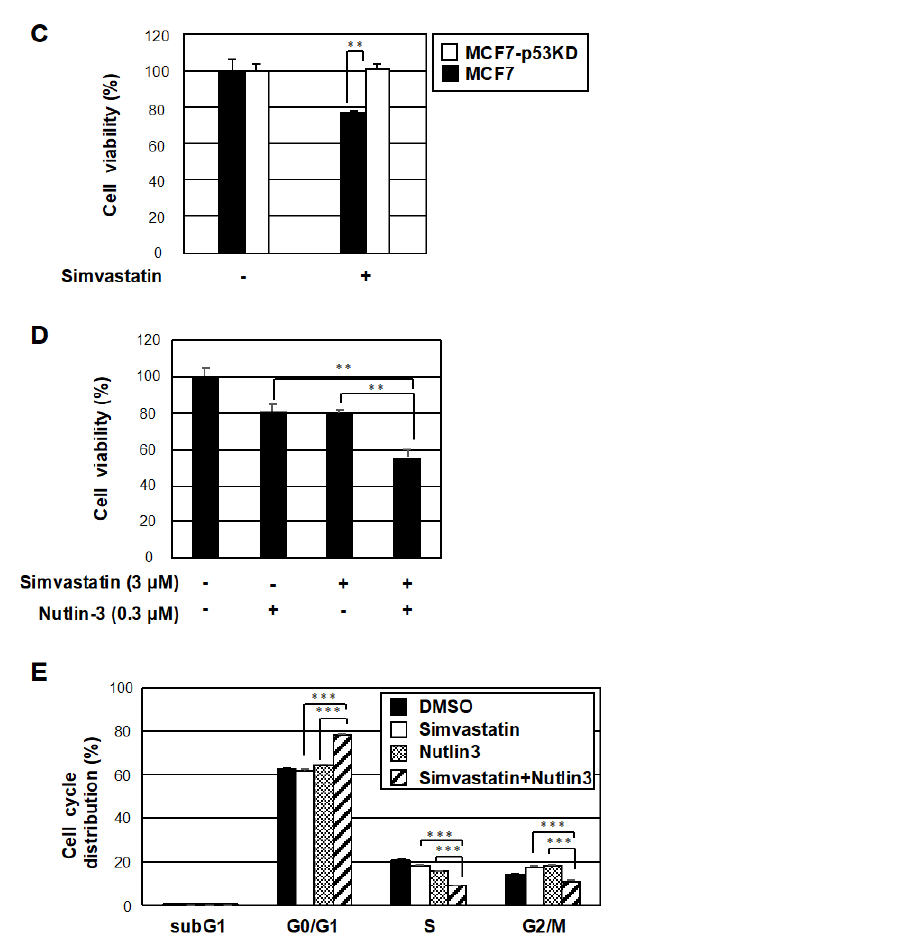
Figure 5. The co-treatment with simvastatin and nutlin-3 efficiently reduced cancer cell survival. ( A ) MCF7 cells were treated with the indicated concentrations of simvastatin. After 48 h, cell viability was measured with a WST-8 cell proliferation assay. Results are shown as means ± S.D. ( n = 3). ( B ) MCF7 cells were treated with the indicated concentrations of nutlin-3. Cells were then analyzed as in ( A ). Results are shown as means ± S.D. ( n = 3). ( C ) MCF7 wild-type cells or MCF7 cells that express shRNA to p53 (p53KD) were treated with the 10 µ M simvastatin. Cells were then analyzed as in ( A ). Results were shown as means ± S.D. ( n = 3). ( D ) MCF7 cells were treated with 0.3 µ M nulin-3 in the presence or absence of 3 µ M simvastatin. Cells were then analyzed as in (A). Results were shown as means ± S.D. ( n = 3). Significant differences are indicated as ** p < 0.01. ( E ) MCF7 cells were treated with 0.5 µ M nulin-3 in the presence or absence of 7 µ M simvastatin. After 48 h, cells were stained with propidium iodide for a flow cytometric analysis of DNA content. Significant differences are indicated as ** p < 0.01, *** p < 0.001.